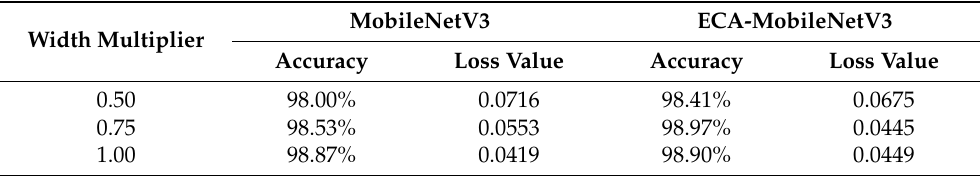
Table 4. Comparison table of accuracy and loss values for different-width multipliers on Shanghai Hongqiao Airport